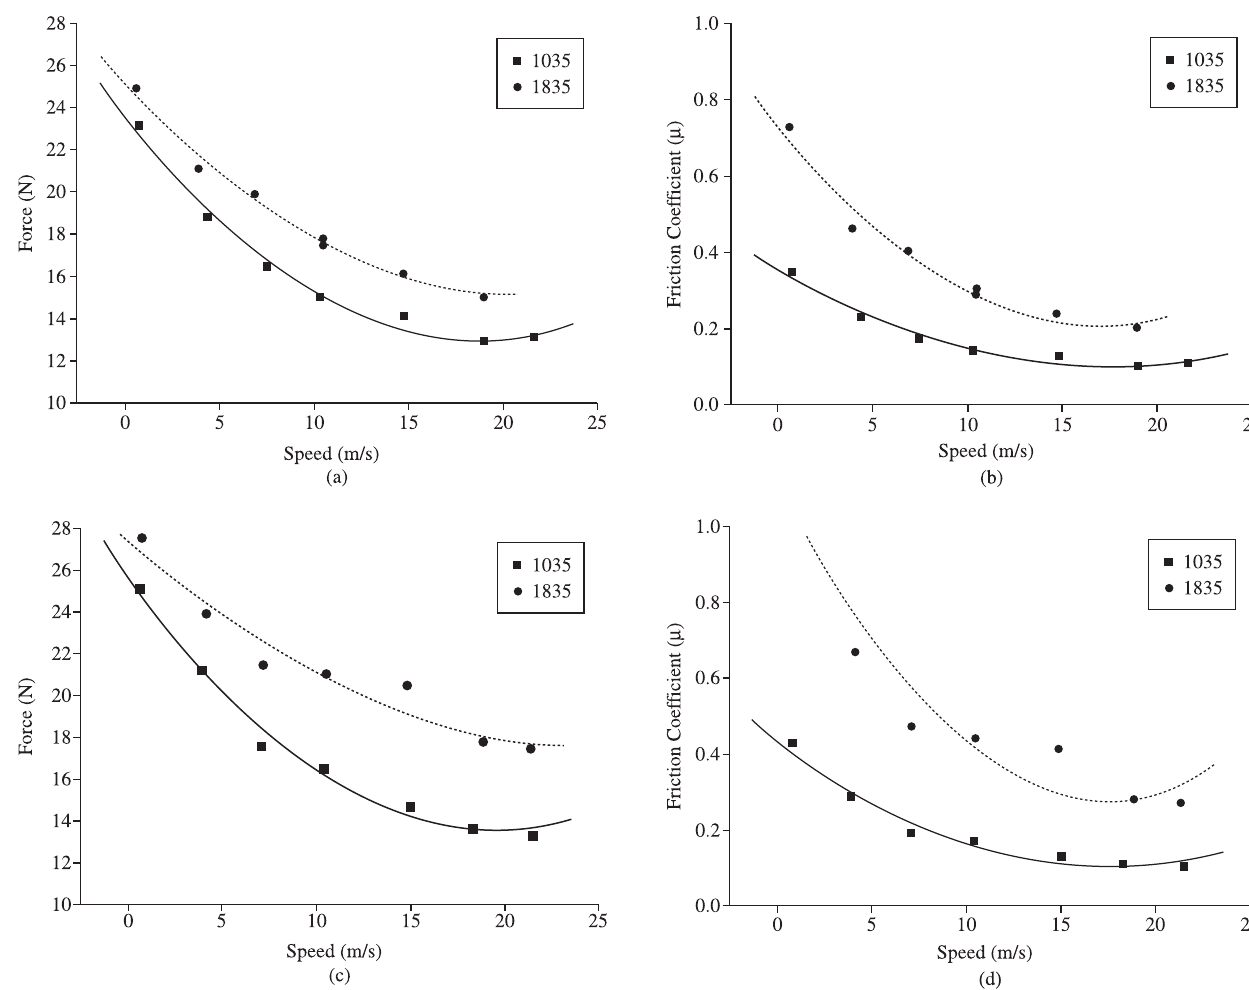
Figure 3. Wiredrawing forces and friction coefficient in relation to the wiredrawing velocity for 2 β = 10° and 2 β = 18°, considering Hc = 35% and Hc =